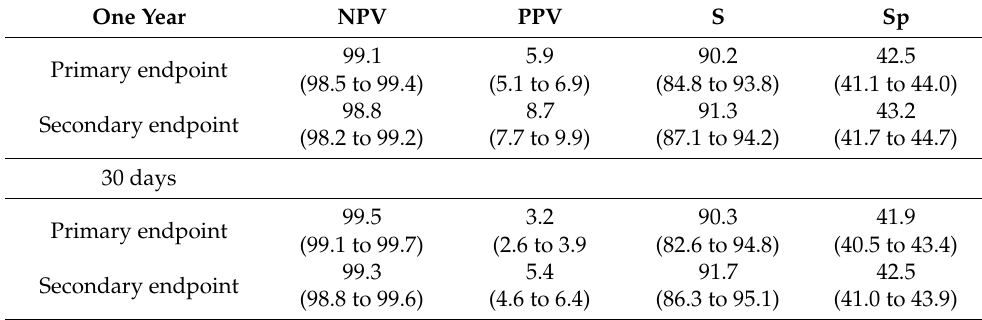
Table 2. Negative and positive predictive values (NPV and PPV), sensitivity (S), and specificity (Sp) of hs-cTnT at the detection limit (5 ng/L), for the primary (death or acute myocardial infarction) and secondary (death or acute myocardial infarction or urgent revascularization)